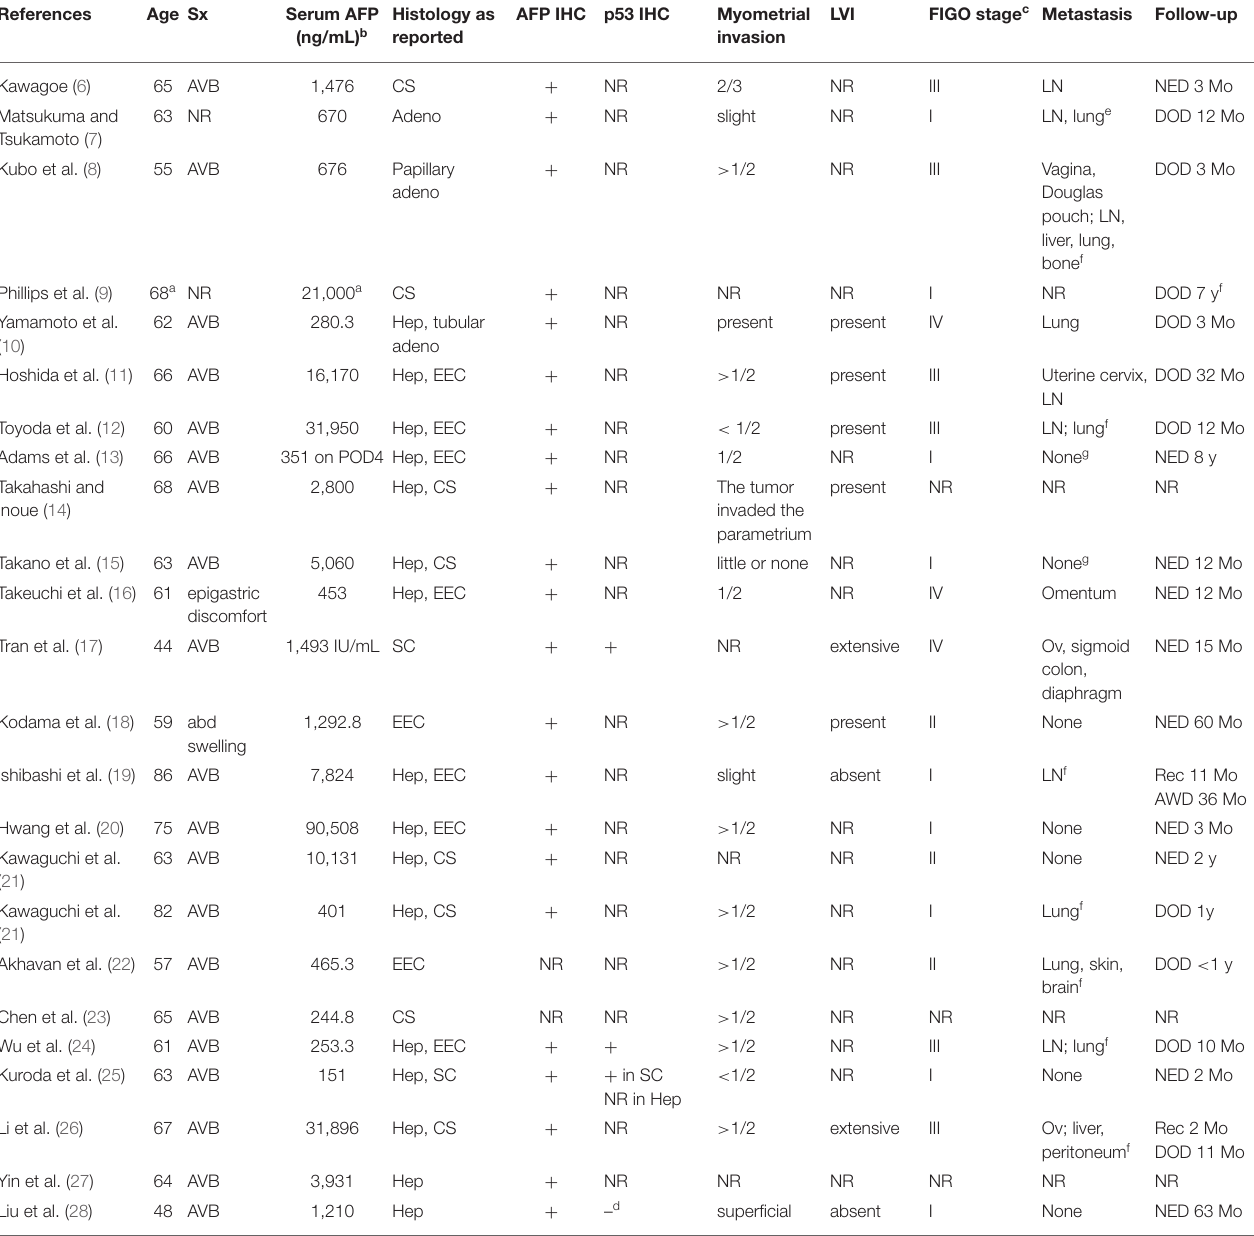
TABLE 2 | Reported cases of AFP-producing endometrial carcinoma.